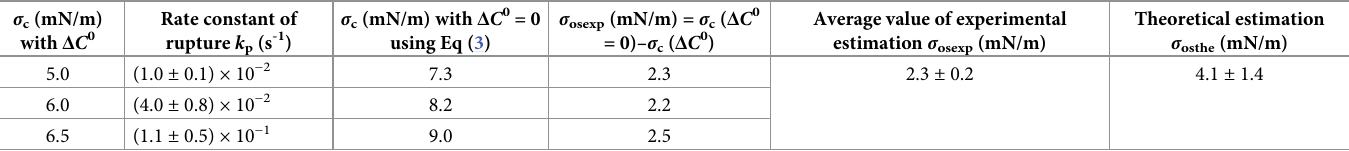
Table 1. An estimation of membrane tension of DOPG/DOPC/chol (46/39/15)-GUVs for Δ C 0 = 15 mOsm/L and C out = 373 mOsm/L. Rate constant of σ c (mN/m) σ c (mN/m) with Δ C 0 = 0 with Δ C 0 rupture k p (s -1 ) using Eq (3)